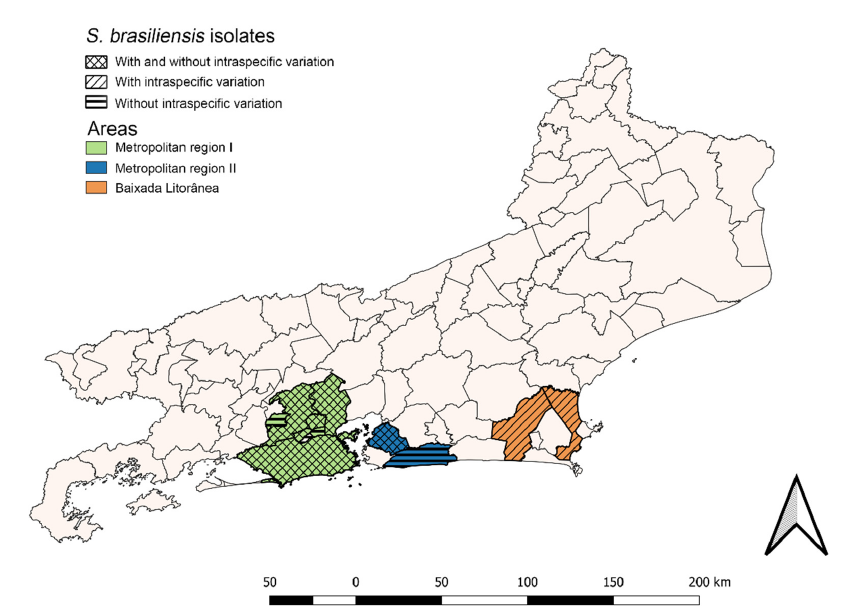
Figure 3. Geographic distribution of the 119 feline cases of sporotrichosis seen at the Laboratory of Clinical Research on Dermatozoonoses in Domestic Animals (INI/Fiocruz), Rio de Janeiro, Brazil (1998 to 2018).